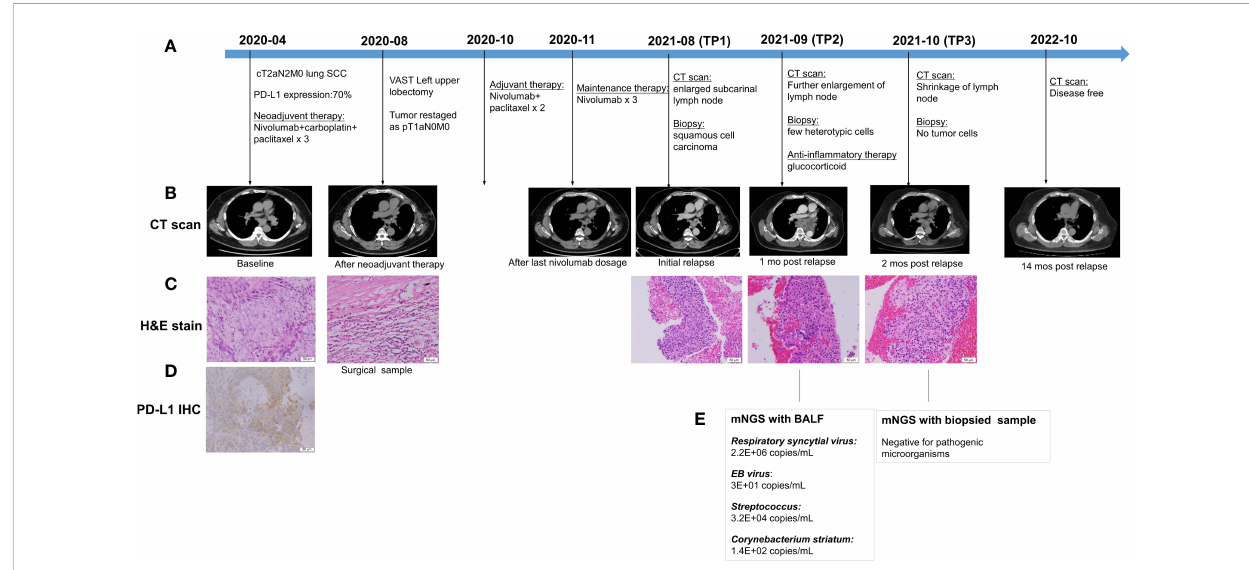
FIGURE 1 The clinical course of the patient (A) Timeline showing the clinical course; (B) Change of the tumor lesion revealed by CT scan; (C) Hematoxylin and Eosin (H&E) stain of biopsied and surgical samples; (D) PD-L1 expression assessed by immunohistochemistry (IHC) assay; (E) Results of metagenomic next-generation sequencing (mNGS) with patient ’ s bronchoalveolar lavage fl uid (BALF) and biopsied sample. TP1: initial relapse; TP2: 1 month after relapse; TP3: 2 months after